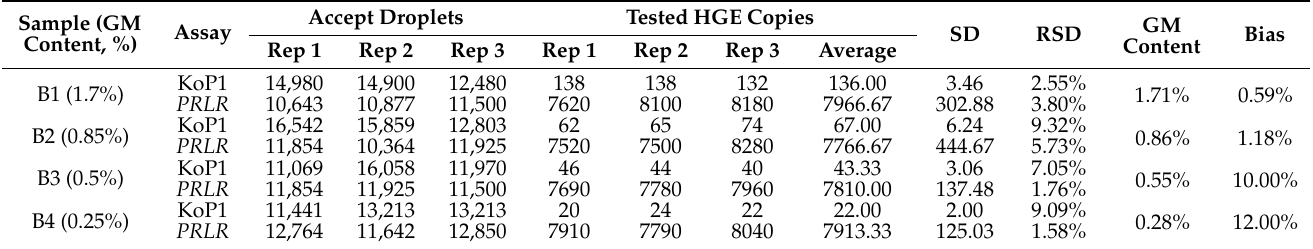
Table 4. Quantification of the GM KoP1 contents of four simulated blood DNA samples with ddPCR assays.